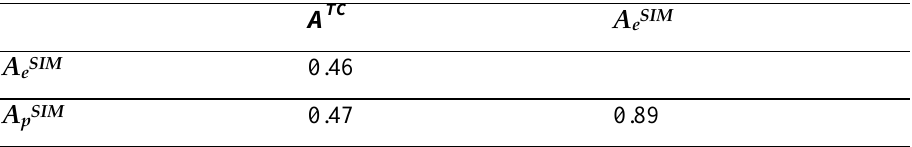
Table 6. Coefficient of correlation between the accessibility